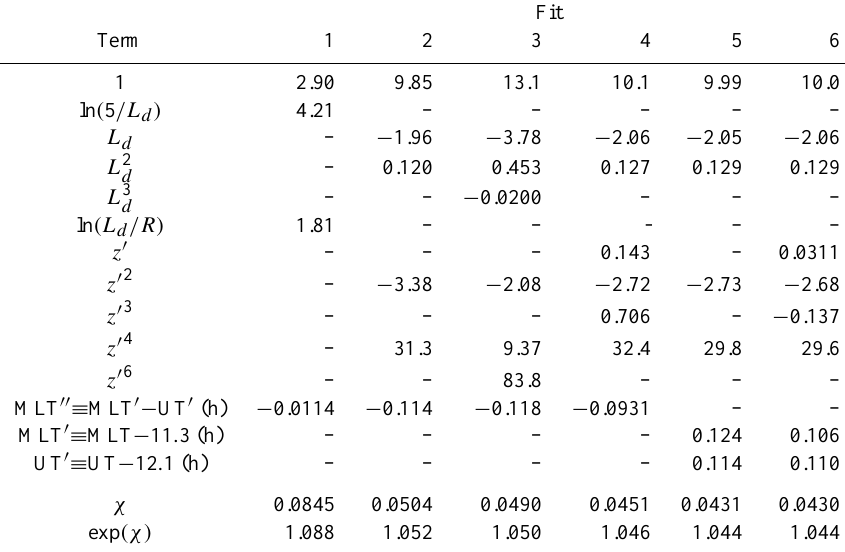
Table 1. Fit coefficients for ln (n e ) for 10 Septtember 2002